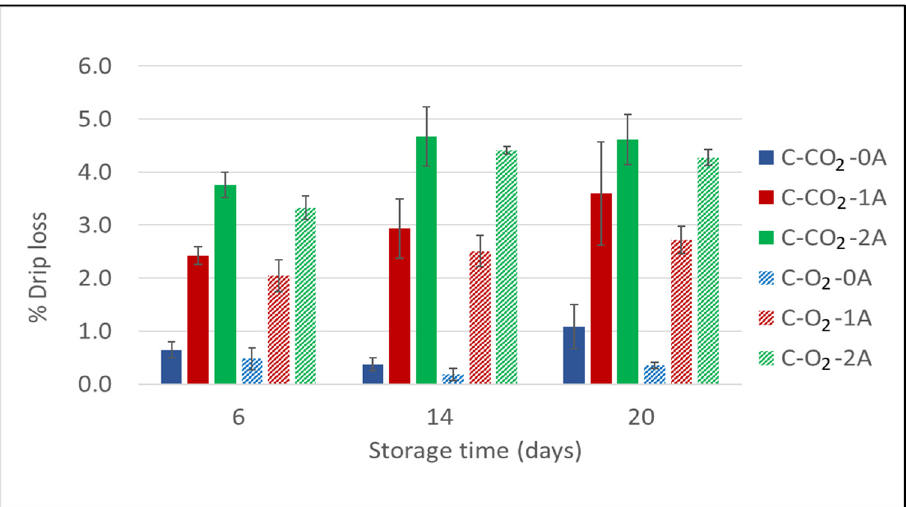
Figure 1. Drip loss for chicken breast fillets expressed as a percentage (%) of initial product weight as a function of storage time for chicken breast fillets (C) packaged in modified atmospheres of 60% CO 2 /40% N 2 (C-CO 2 ) and 75% O 2 /25% CO 2 (C-O 2 ) with 0, 1, or 2 liquid absorbent pads (0A, 1A, 2A). g/p ratio for all samples was 1.8 (Experiment 1). Sampling times were after 6, 14, and 20 days of cold storage. For each bar, the error bars indicate +/ − one standard error.